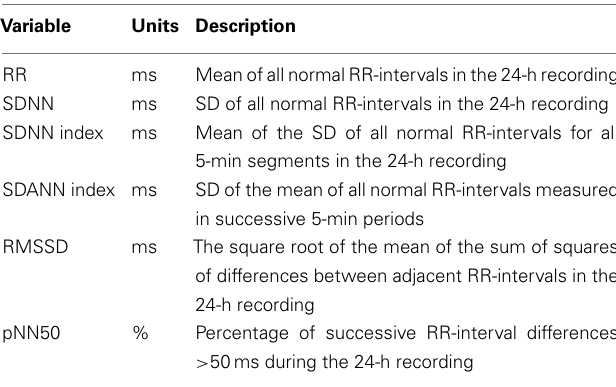
Table 1 | Definition of time domain HRV variables obtained from 24-h Holter